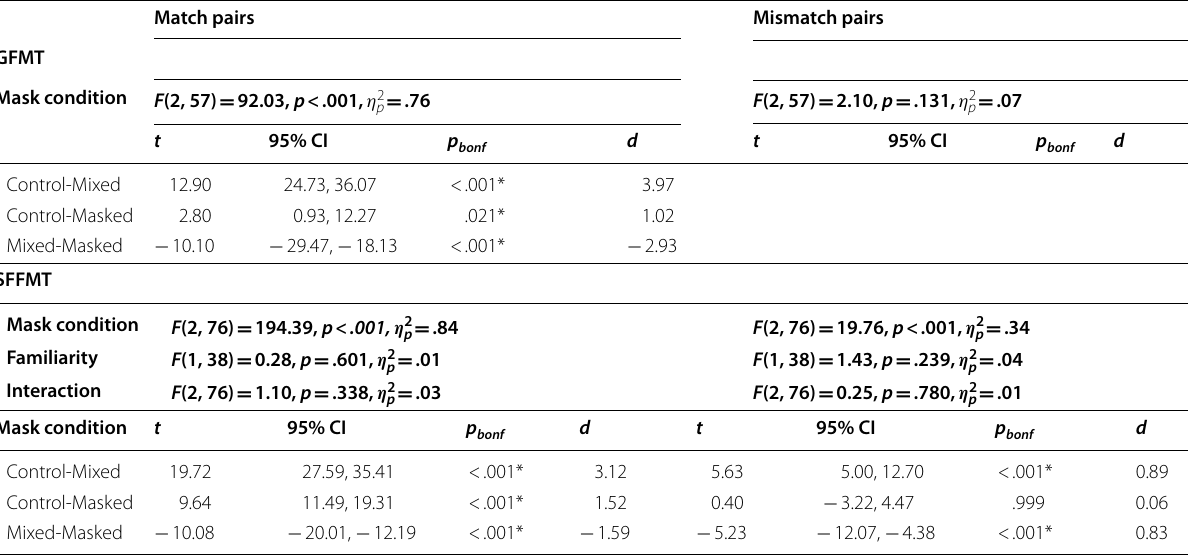
Table 7 Separate item-analysis ANOVAs and post hoc analyses for the similarity ratings given by the DNN for match and mismatch trials of the GFMT and the SFFMT